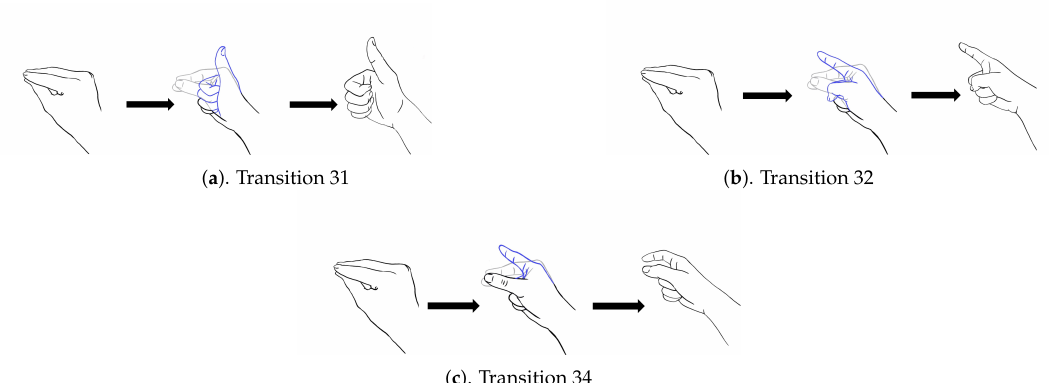
Figure 10. Three transitions associated with Gesture 2: Transition 21, Transition 23 and Transition 24, where Transition ij denotes transition from Gesture i to Gesture j .